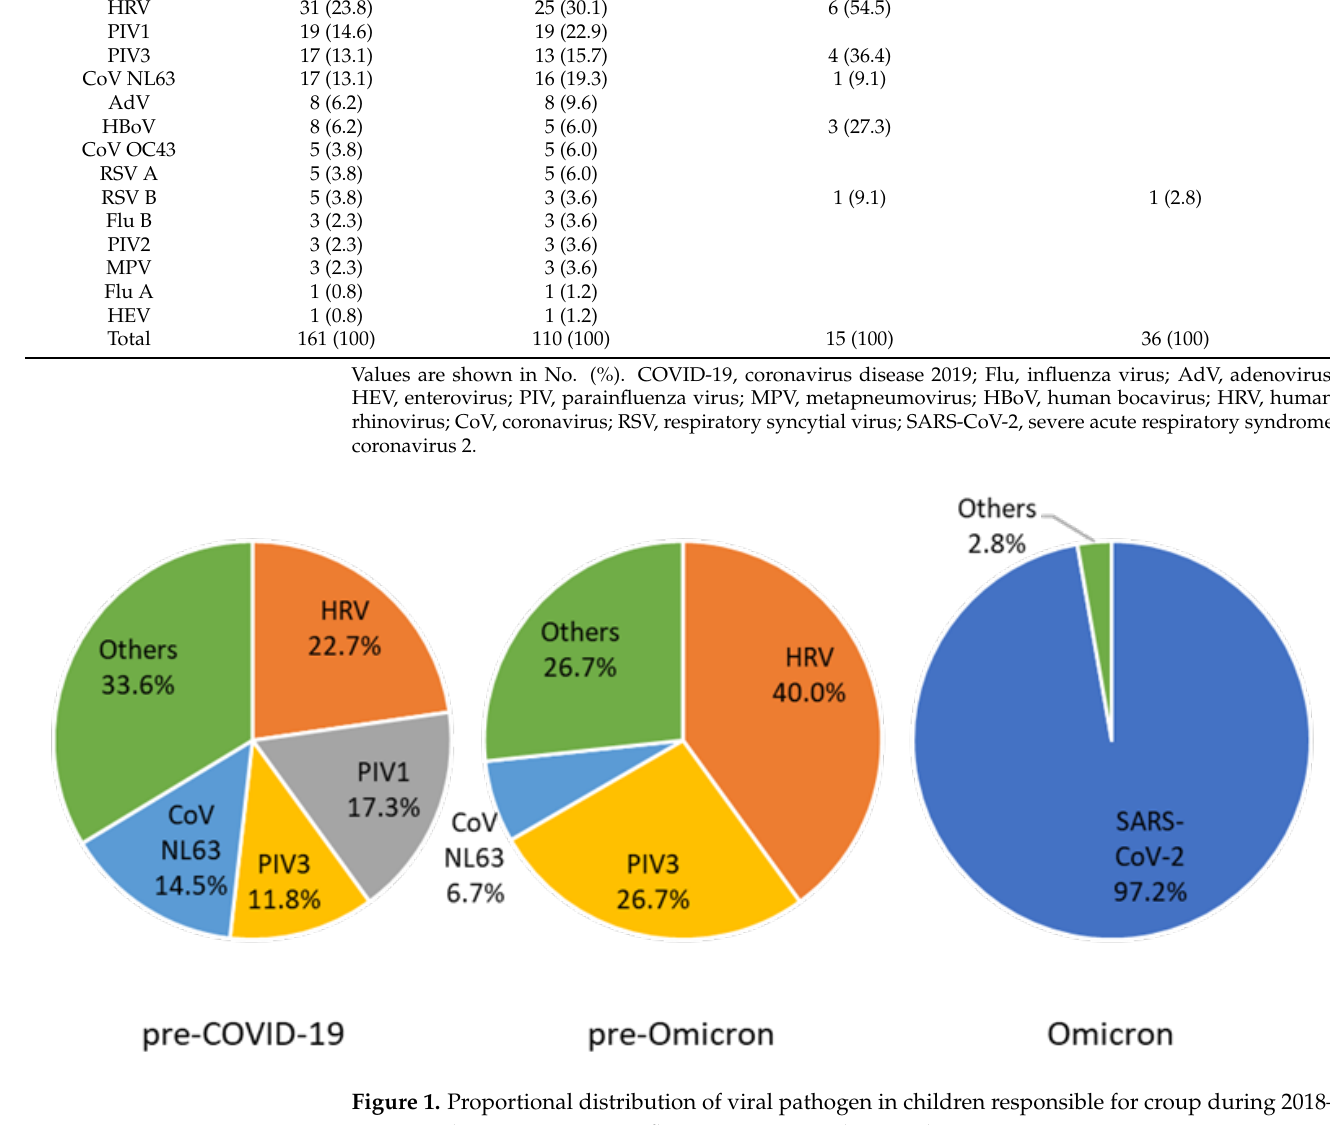
Figure 1. Proportional distribution of viral pathogen in children responsible for croup during 2018–2022, South Korea. PIV, parainfluenza virus; HRV, human rhinovirus; CoV, coronavirus; SARS-CoV-2, severe acute respiratory syndrome coronavirus 2.